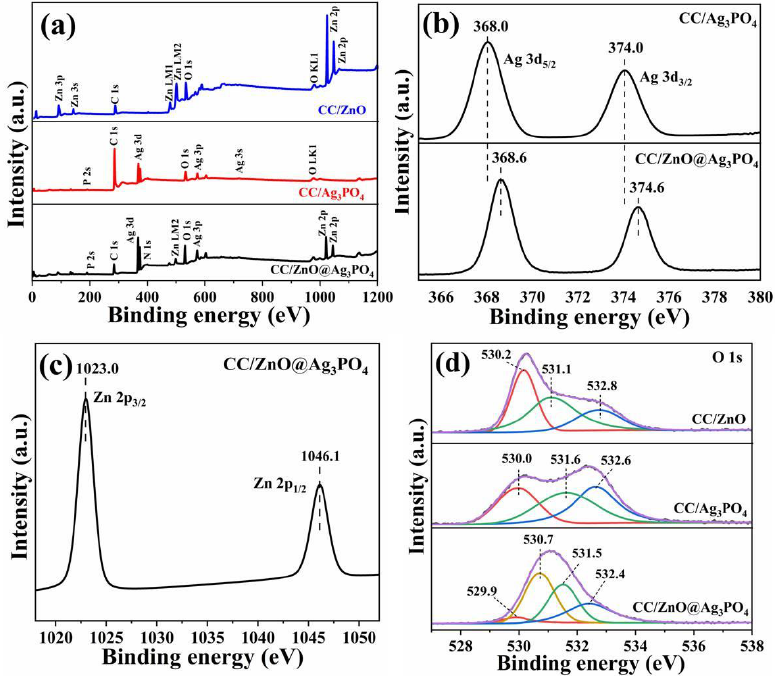
Figure 5. XPS survey spectrum ( a ) and high-resolution XPS spectra of Ag 3d ( b ), Zn 2p ( c ), O 1s ( d ) of CC/ZnO, CC/Ag 3 PO 4 , and the CC/ZnO@Ag 3 PO 4